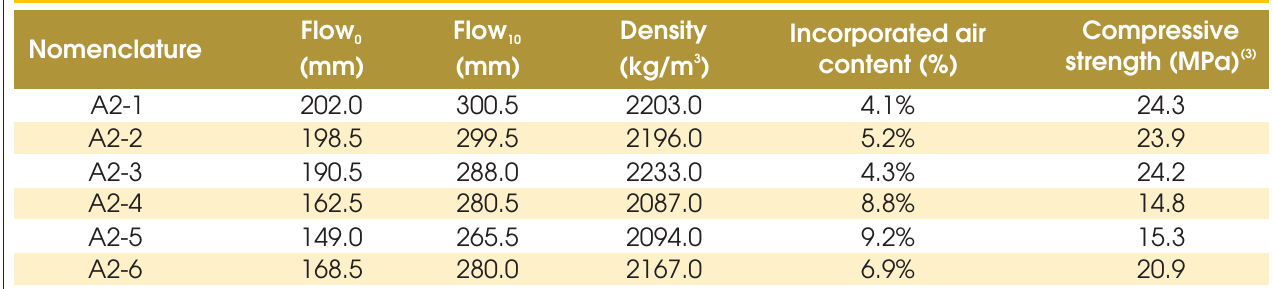
Table 10 – Fresh and hardened state tests results – stage 2